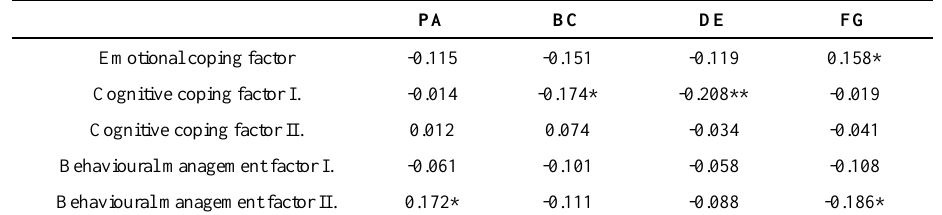
Table 1. Correlations between behaviours in demanding situations of project manager work and characteristics of the interpersonal behaviour of managers. PA BC DE FG